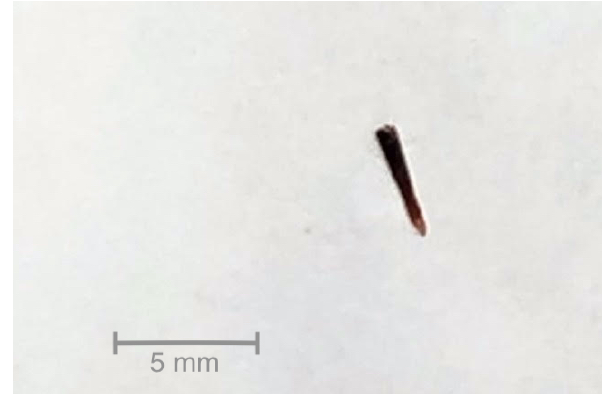
Figure 2. Thorn fragment (4.5mm) removed during arthrotomy from the suprapatellar pouch.